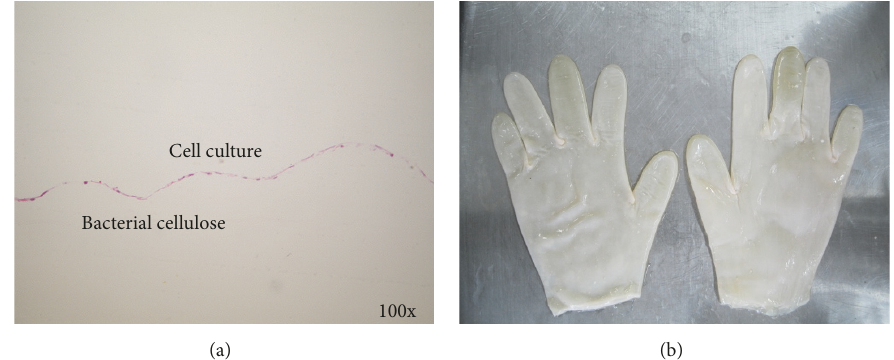
Figure 4: BC wound dressing: (a) side view of BC histology cut, cells adhere on the biomaterial surface (image taken at 100x). (b) BC glove- shaped wound dressing (hydrogel state) for treatment of hand lesions, especially those involving